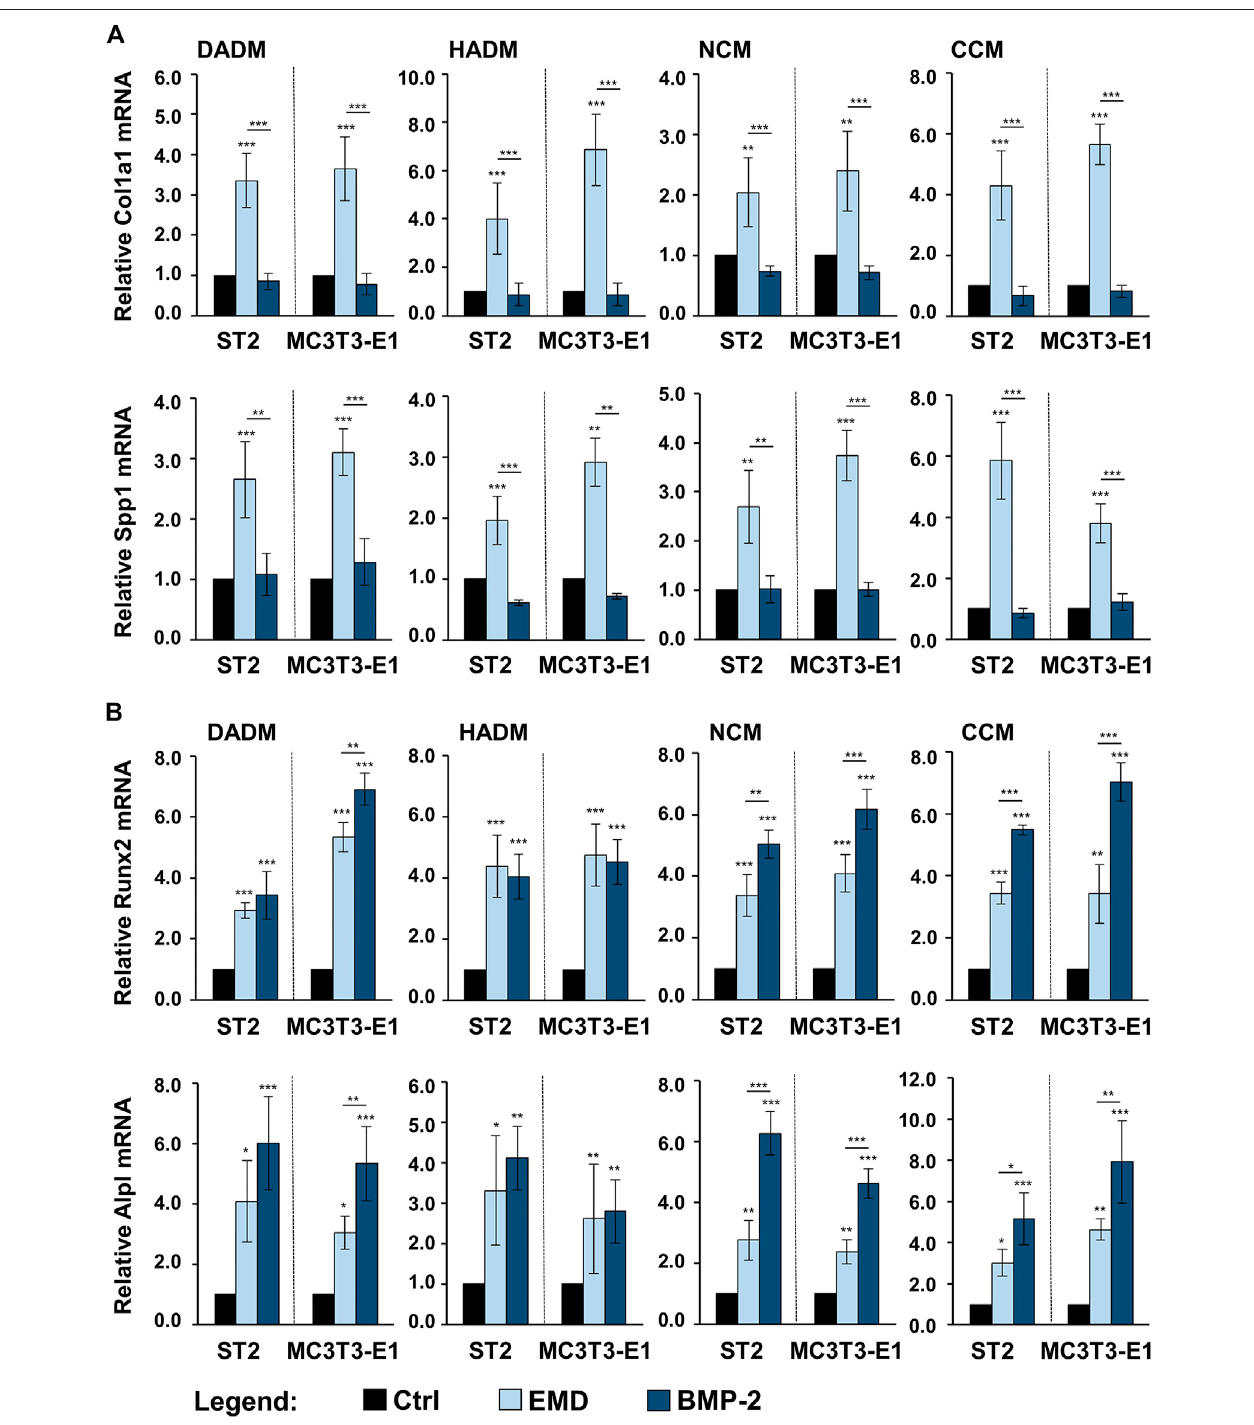
FIGURE 6 | Enhancing effect of collagen-based matrices biofunctionalized with EMD or rBMP-2 on the expression of genes characterizing the early stages of osteogenic differentiation. Each of the two osteoprogenitor cell lines, ST2 and MC3T3-E1, were cultured on DADM, HADM, NCM, or CCM collagen-based matrices under three different conditions: 1) control condition (Ctrl), consisting of cells grown on native/uncoated matrices, 2) cells grown on matrices coated with EMD, and 3) cells grown on matrices coated with rBMP-2. For conditions 2) and 3), collagen matrices were coated for 10 min at room temperature in serum-free DMEM containing 1 mg/ml of EMD or 100 ng/ml of rBMP-2, respectively, followed by extensive wash of the matrices as described in the Materials and Methods section. Cells were grown under the above listed conditions for 3 days before total RNA was extracted and analyzed by qRT-PCR for the expression of Col1a1 and Spp1 (A) , Runx2 and Alpl (B) . Values normalized toGapdh are expressed relativeto the values of the respective control cells. Means ± SD from four independent experiments performed with each of the two cell lines and signi fi cant differences to the control unless otherwise indicated, *** p < 0.001, * p < 0.01, * p < 0.05 are shown.